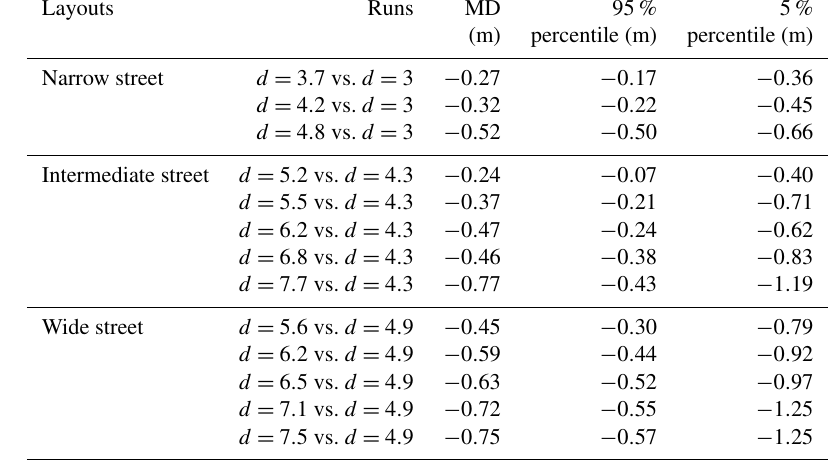
Table 5. Differences between upscaled water depths derived from various runs of Velickovic et al. (2017). Layouts Runs